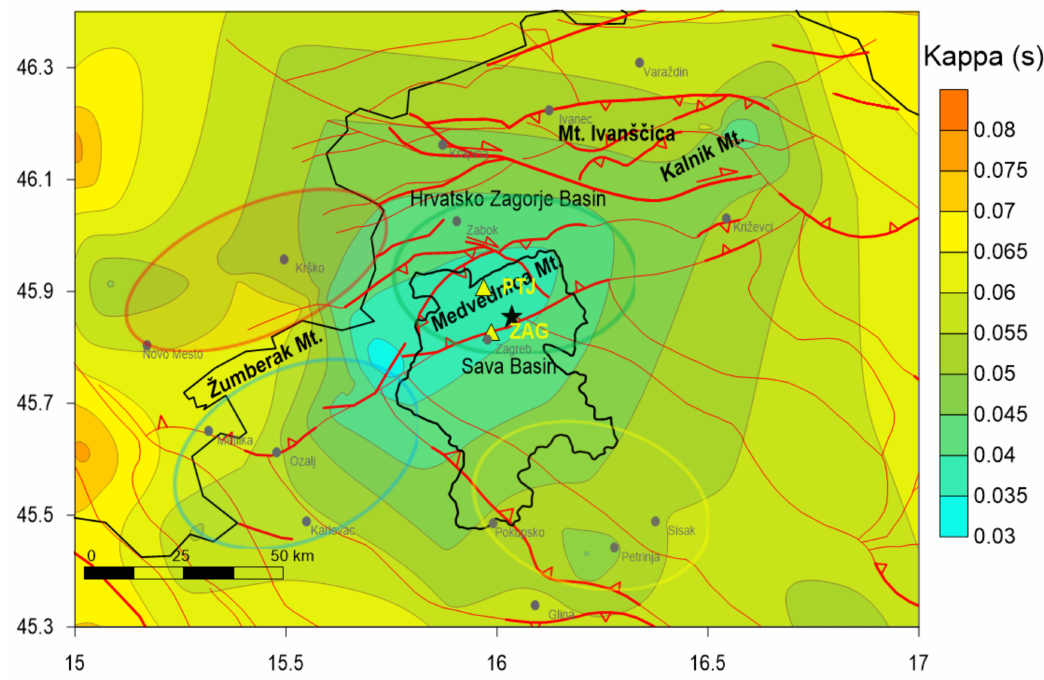
Figure 7. Regional κ dependence around the PTJ and ZAG seismological stations shown as a spatial distribution of individual κ values and plotted using the natural-neighbour interpolation method. The red lines represent the possible seismogenic surface faults in Croatia. Possible active faults are marked with thick lines [28,29]. The Zagreb city area is marked with a thick black polygonal line and seismic zones Novo Mesto-Krško, Karlovac-Metlika, Pokupsko-Petrinja and Zagreb are marked with colours as shown in Figure 2. The M5.5 earthquake of 22 March 2020, with the epicentre 7 km north of the Zagreb city centre, is marked with a black